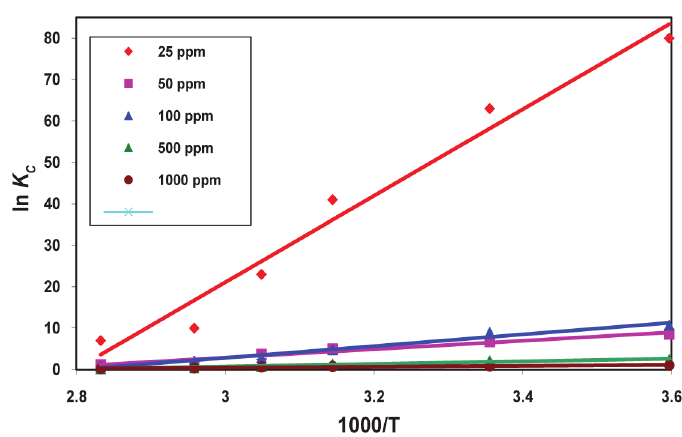
Fig. 7 – Van’t Hoff plot for removal of different initial dye concentrations using isolated 40B biopolymer at dif- ferent solution